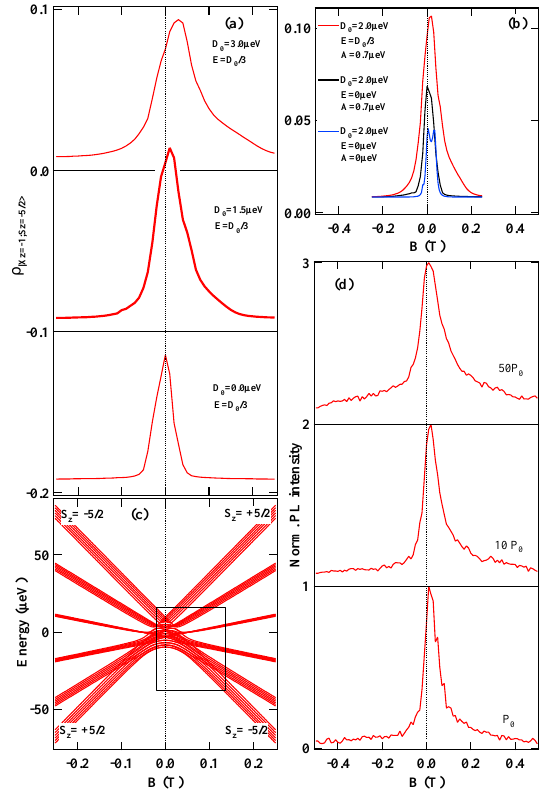
Figure 13: (a) Modelling of the longitudinal magnetic field depen- dence of the population of the exciton state | X z = −1, S z = −5/2 ⟩ under resonant excitation for different values of the crystal field terms D 0 and E = D 0 /3 (the curves are vertically shifted for clarity). The population of this level is proportional to the resonant PL sig- nal. The parameters used in the calculation (see text for details) are (cid:126) Ω R = 15 µ eV, τ Mn = 100 ns, τ r = 0.3 ns, τ relax = 50 ns, τ d = 100 ps, A = 0.7 µ eV, a = 0.32 µ eV, and g Mn = 2 . (b) Calculated population of the exciton state | X z = −1, S z = −5/2 ⟩ for D 0 =2 µ eV and E=D 0 /3 (red), E=0, (black), E=0 and A = 0 (blue). (c) Calcu- lated fine and hyperfine structure of a Mn spin with A = 0.7 µ eV, a = 0.32 µ eV, g Mn = 2 , D 0 =1.5 µ eV, and E=D 0 /3. The black rect- angle highlights the magnetic field range where the state S z = − 5/2 significantly interacts with the other Mn spin states. (d) Experimen- tal magnetic field dependence of the resonant PL signal for different excitation intensities and σ − excitation / σ + detection on the high and low energy lines, respectively. The curves are normalized and vertically shifted for